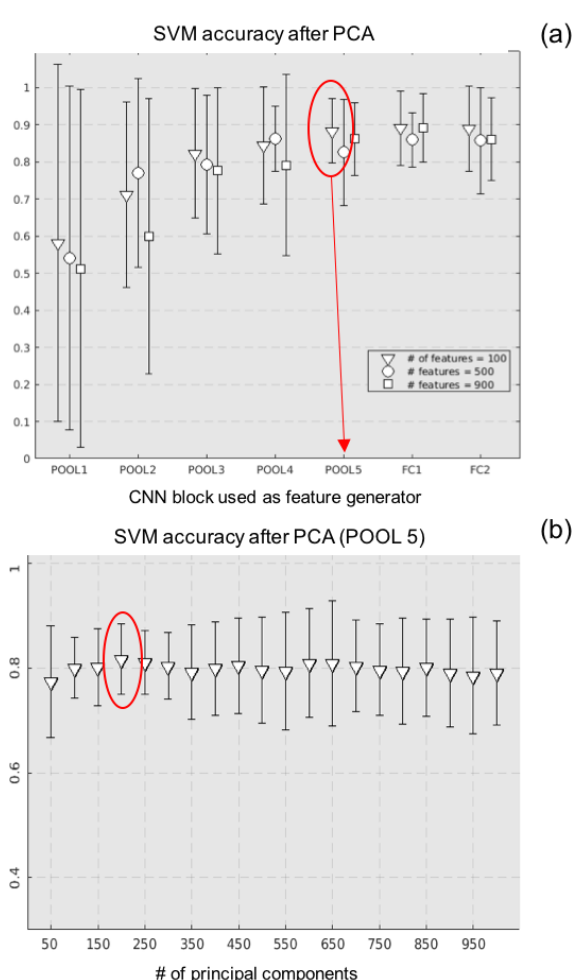
Figure 6. Optimization of the classification framework. ( a ) SVM accuracy versus the CNN block used as the feature generator, at different values of principal components imposed on the PCA. The bars extend from the minimum to the maximum accuracy value obtained by each of the five polyp categories (best configuration circled in red). ( b ) SVM accuracy versus the number of principal components imposed on the PCA, with the POOL5 block used as the feature